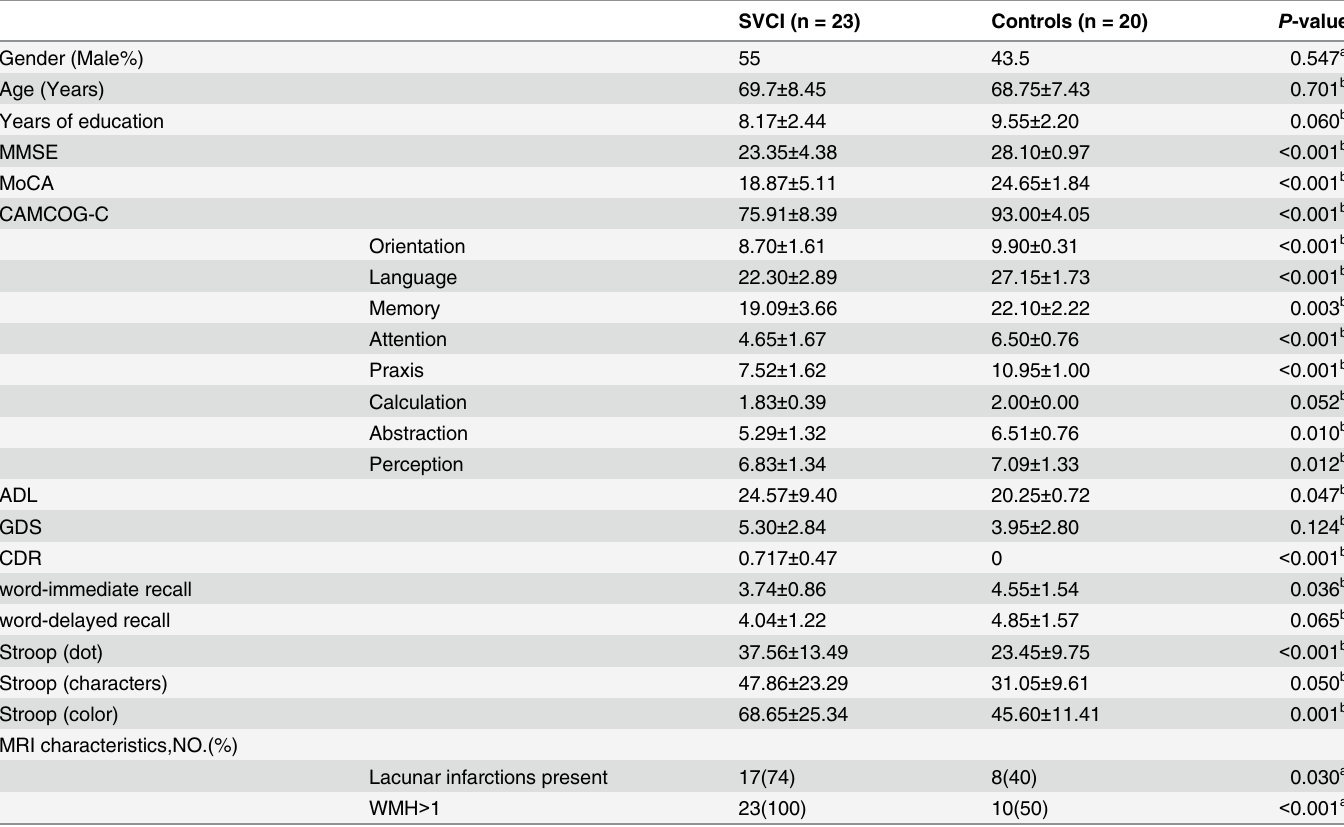
Table 1. Demographic and neuropsychological